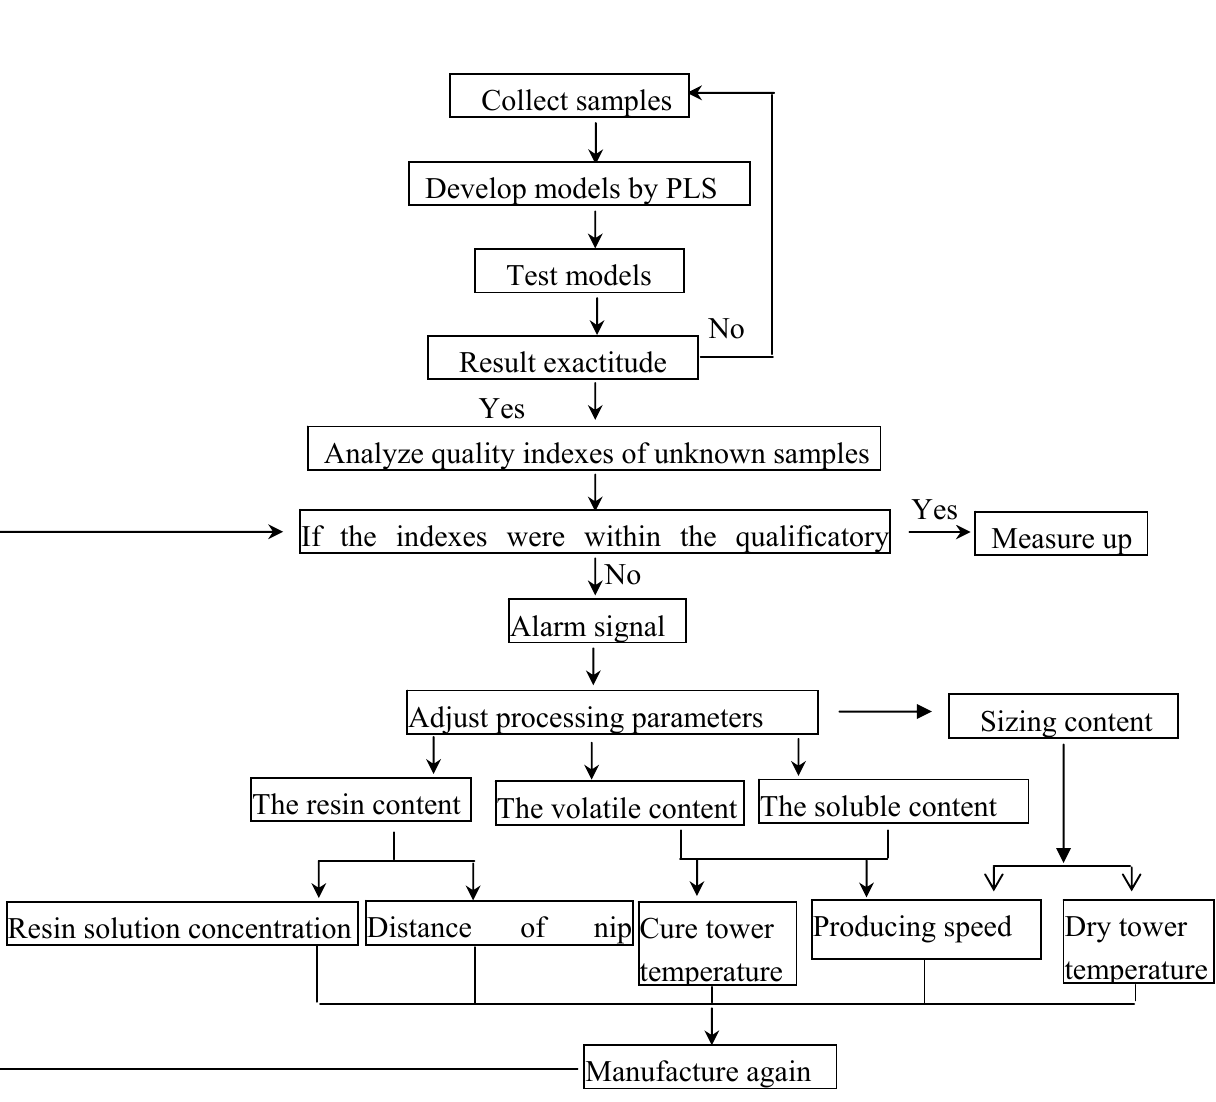
Figure 6. On-line monitor of prepreg quality by